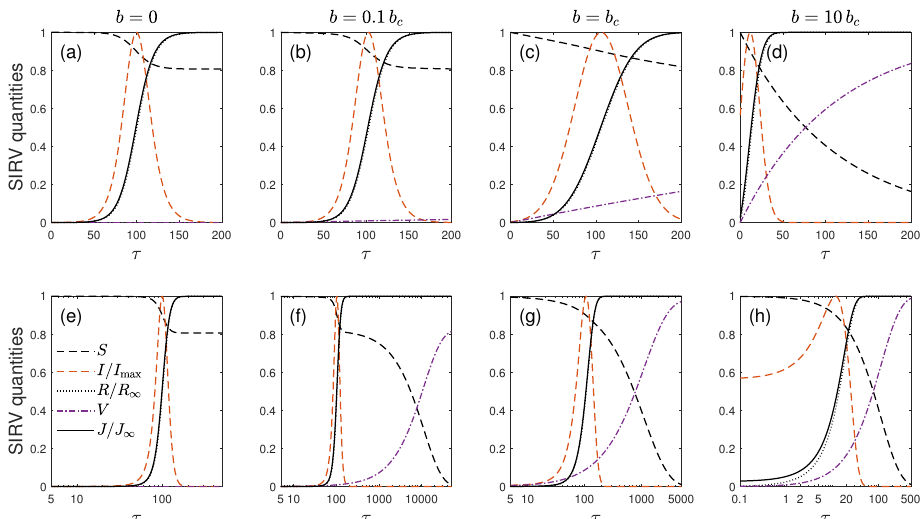
Figure 9. Suitable normalized SIRV quantities S , I / I max , R / R ∞ , V , and J / J ∞ versus τ for the four different reduced vaccination rates at k = 0.9 and η = 10 − 6 : ( a , e ) b = 0 (SIR model), ( b , f ) b = 0.1 b c , ( c , g ) b = b c , and ( d , h ) b = 10 b c . While the upper row presents the data in a linear scale, the bottom row shows the same but in a semilogarithmic fashion to appreciate the two well separated time